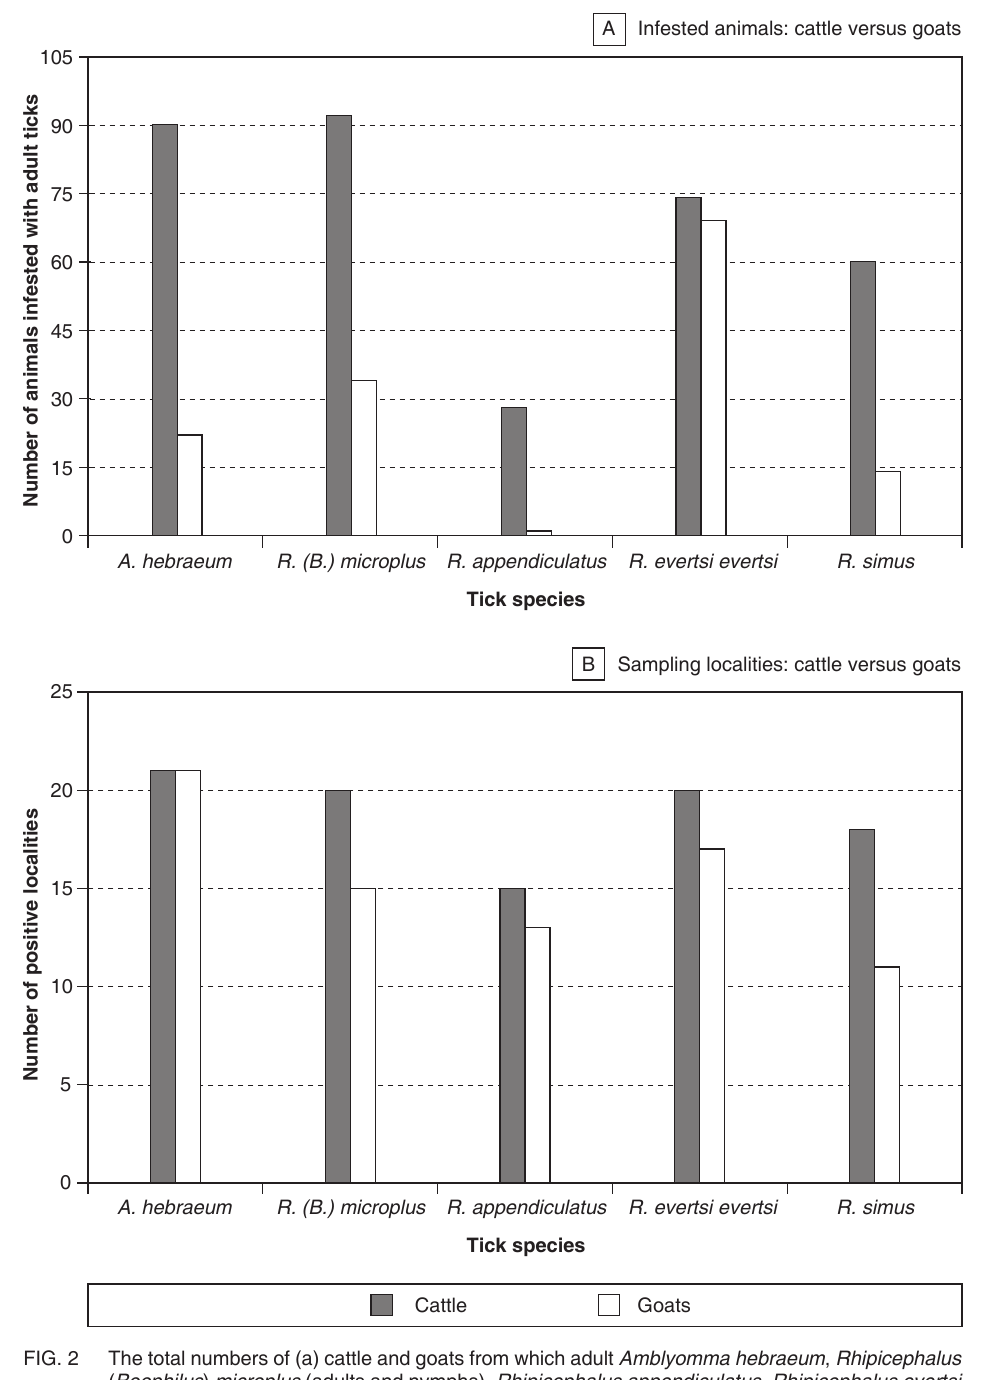
The total numbers of (a) cattle and goats from which adult Amblyomma hebraeum , Rhipicephalus ( Booph i lus ) microplus (adults and nymphs), Rhipicephalus appendiculatus , Rhipicephalus evertsi evertsi and Rhipi cephalus simus were collected in Maputo Prov ince, Mozambique and (b) locali- ties at which adults, or adults and nymphs of these species were